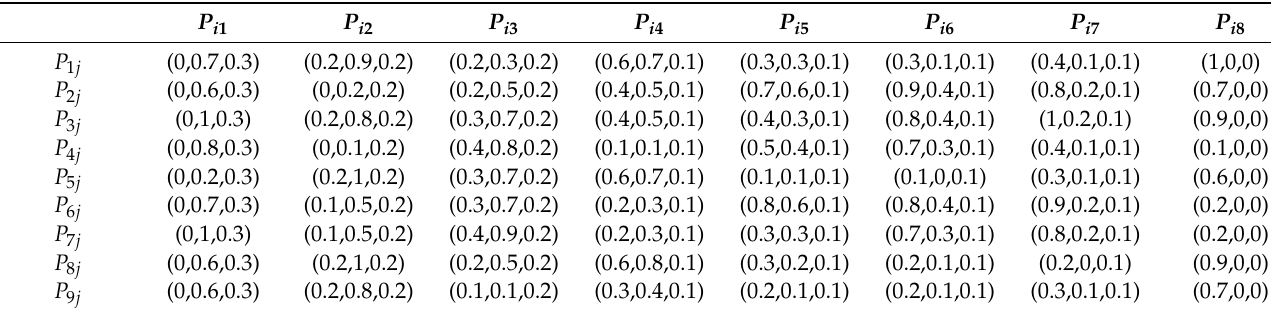
Table 6. Coordinates of the weighted reference points.